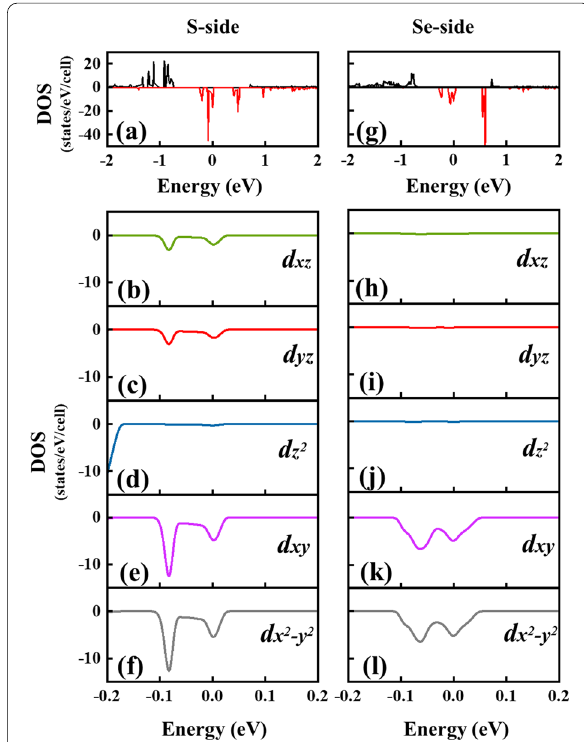
Fig. 5 DOS of Fe-adsorbed system with different adsorption surface, a on the S adsorption surface; b on the Se adsorption surface. c – g The 3d-orbital decomposed DOS of Fe atom adsorbed on the S surface. h – l The 3d-orbital decomposed DOS of Fe atom adsorbed on the Se